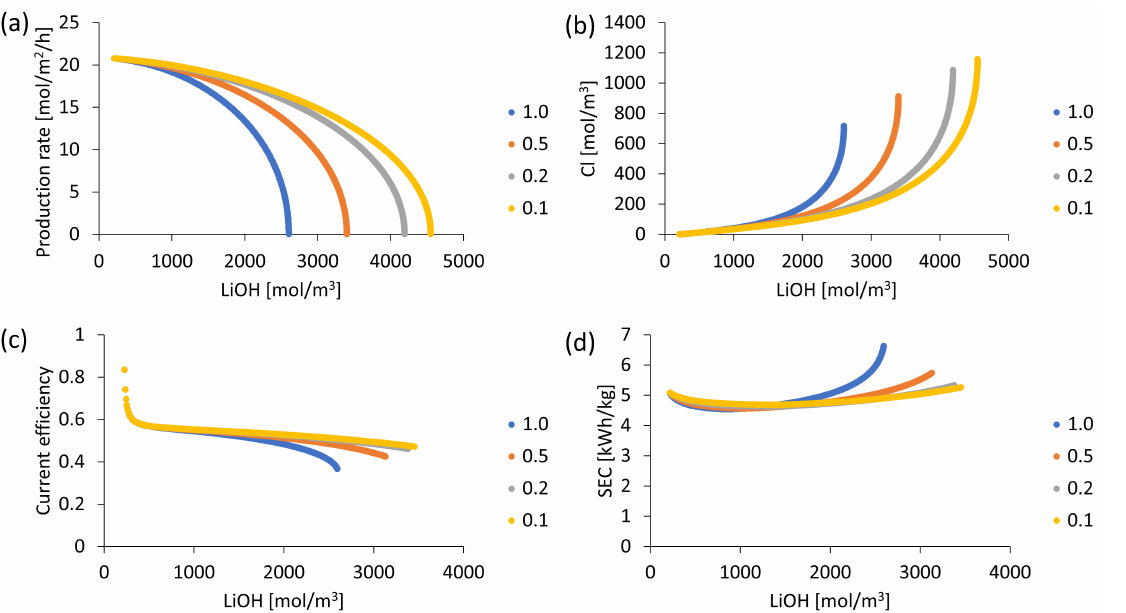
Figure 11. Treated volume ratio effect of HCl and LiOH. Used 6800 mol/m 3 LiCl and 210 mol/m 3 LiOH, current density 1000 A/m 2 : ( a ) LiOH production rate; ( b ) Cl − concentration; ( c ) Current effi ‐ ciency; ( d ) Specific electricity consumption (SEC).